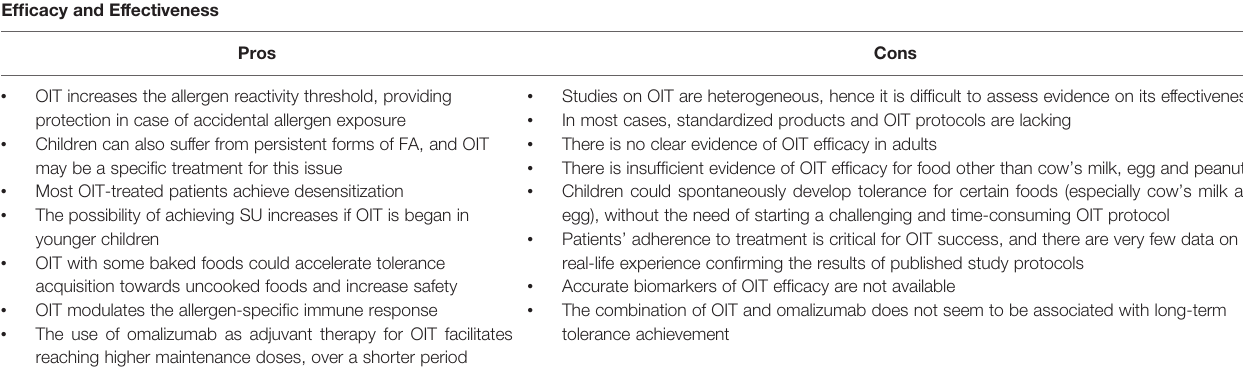
TABLE 1 | Ef fi cacy and effectiveness of OIT in children – pros and cons. Ef fi cacy and Effectiveness Pros